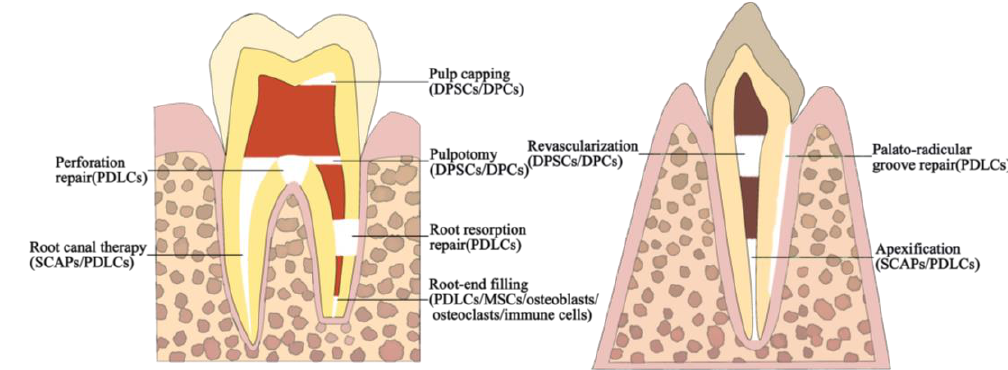
Figure 2. Schematic diagram of a clinical application of bioceramics in endodontics. Cells surrounding the bioceramics are shown in parentheses.